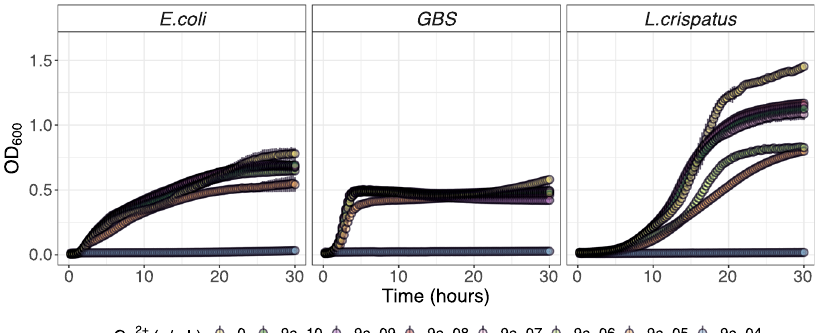
Fig.4|Growthcurvesof Lactobacilluscrispatus , Streptococccusagalactiae ,and Escherichia coli over30h in thepresenceofmediaalone(yellow) or increasing concentration ofCopper (Cu 2+ ) ions. Data represent triplicates of each sample at